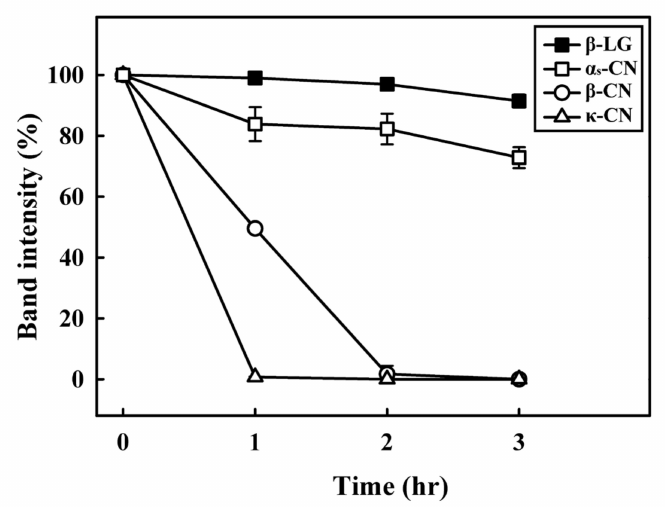
Figure 3. Densitogram corresponding to SDS-PAGE analysis of α s -CN, β -CN, κ -CN, and β -LG treated with chymosin (0.03 units/mL) at 30 ◦ C for 0, 1, 2, and 3